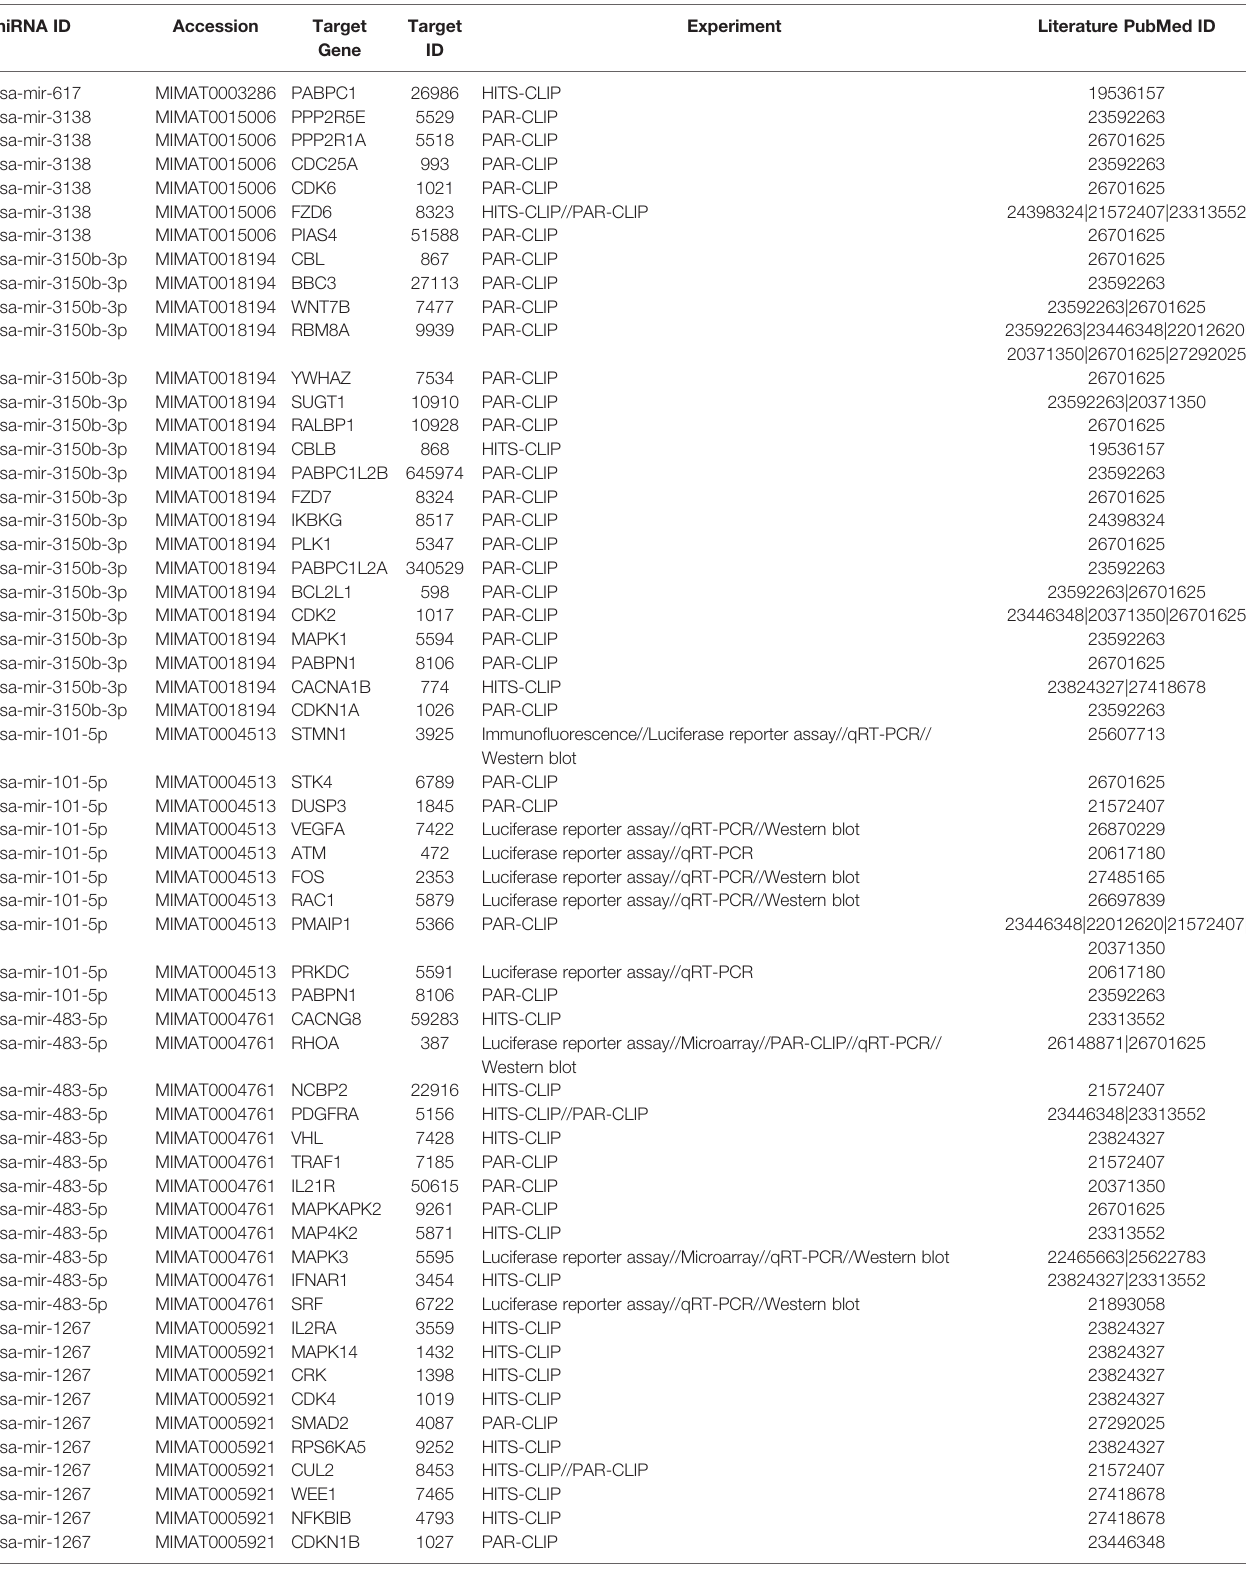
TABLE 3 | Upregulated miRNAS and target genes in response to silencing PGRMC1. miRNA